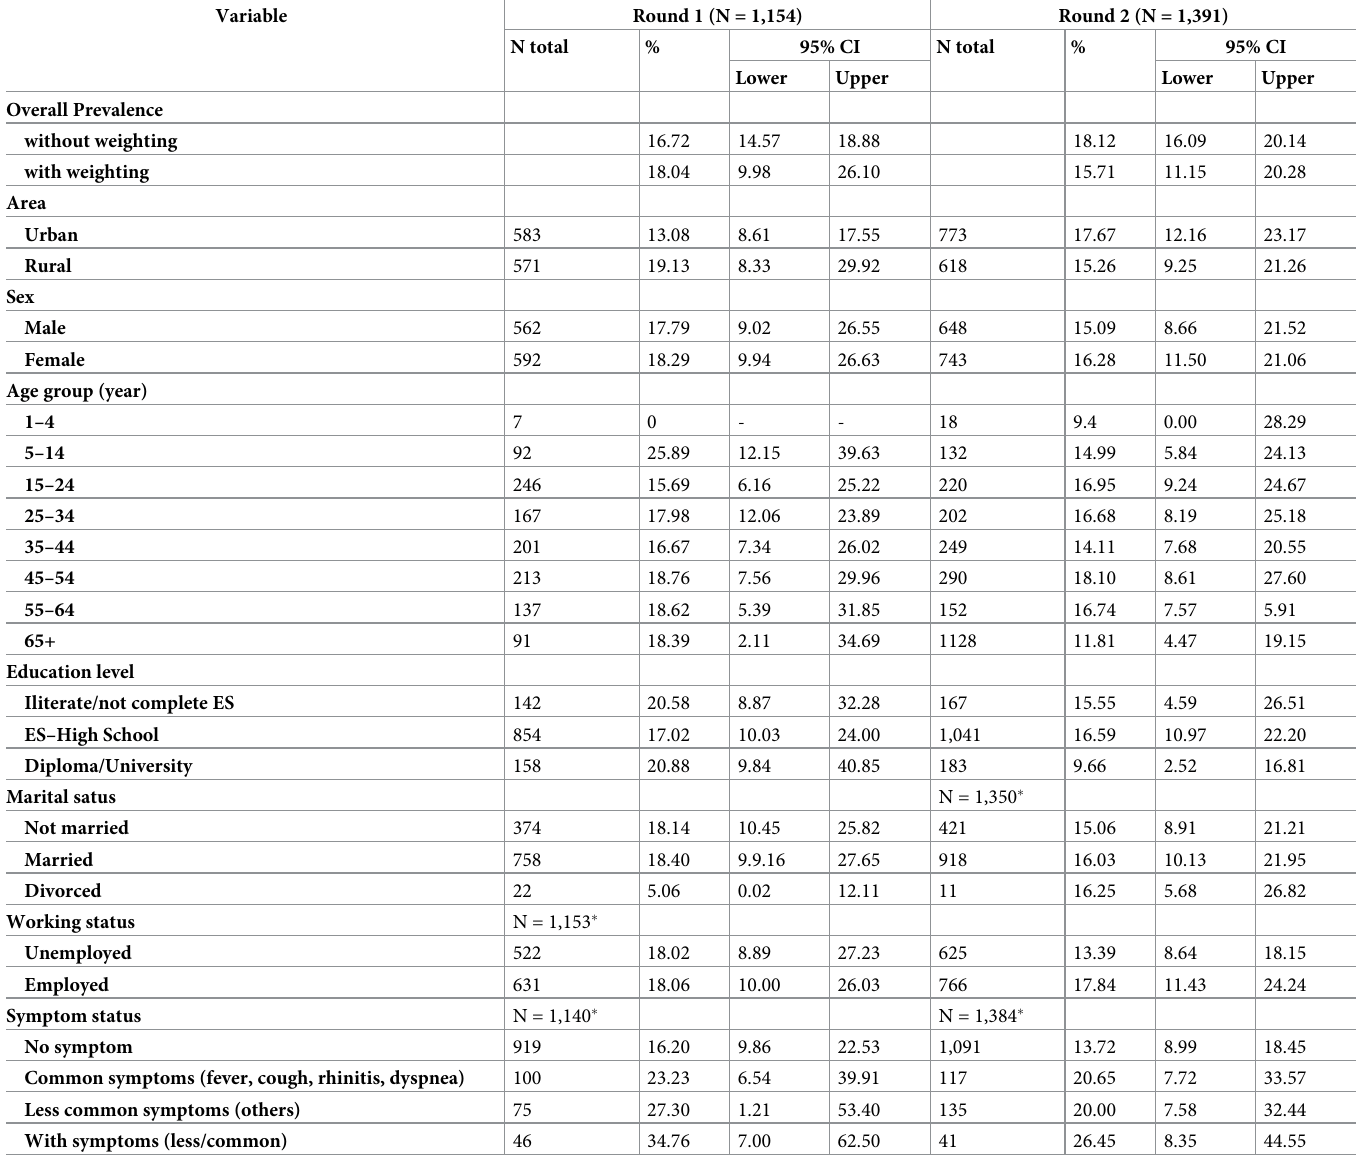
Table 3. Seroprevalence of